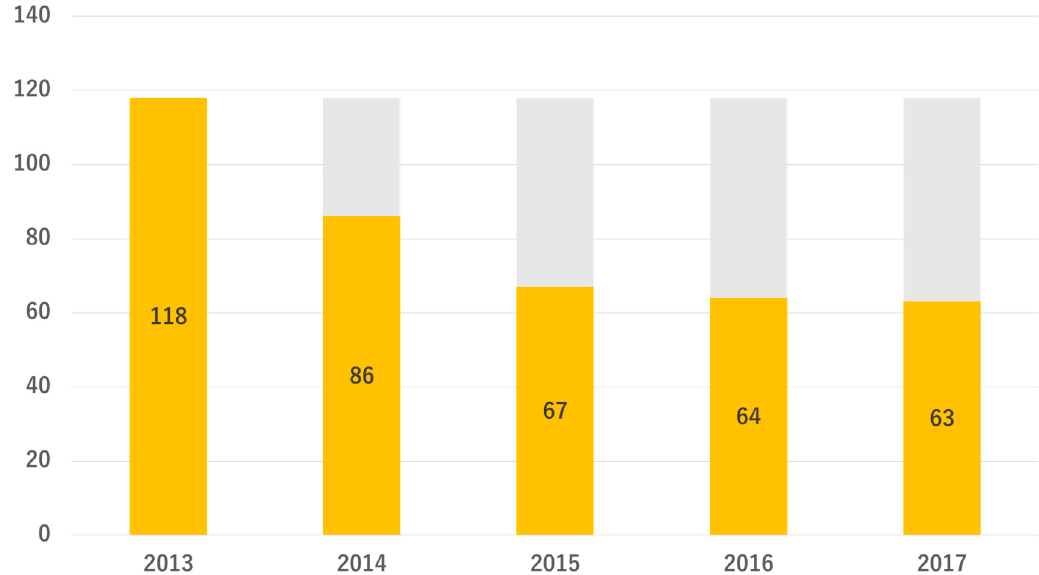
Figure 1. Diagram of participants enrolled in this study.